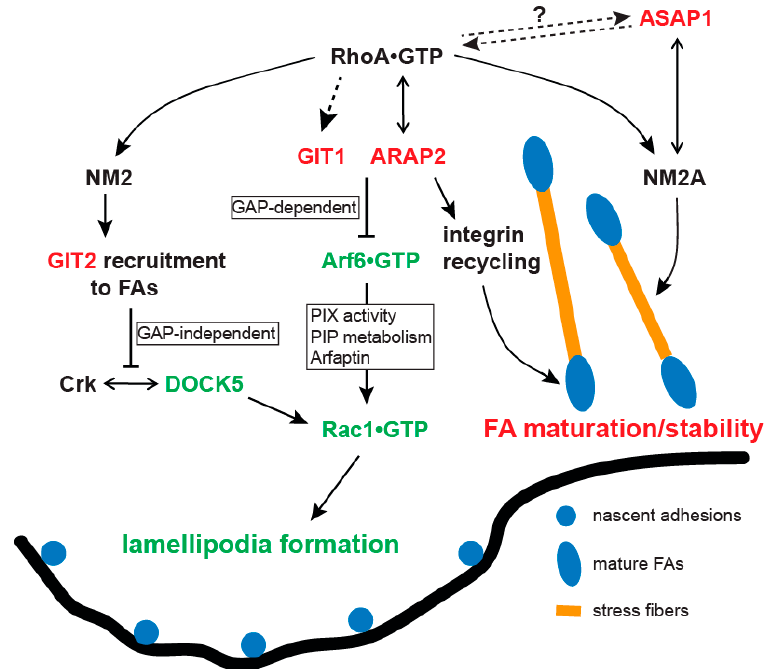
Figure 2. The roles of ASAP1, GITs and ARAP2 in the regulation of actin structures involved in lamellipodia-dependent cell migration. The cartoon illustrates the pathways that ASAP1, GITs and ARAP2 control to modulate the antagonistic relationship between lamellipodia formation and stress fiber formation/focal adhesion (FA) maturation. Arrows indicate positive/stimulatory regulation while ⊥ indicates negative/inhibitory regulation. Double arrows indicate binding. Dash lines denote possible regulation and the question mark denotes ASAP1 may function upstream or downstream from